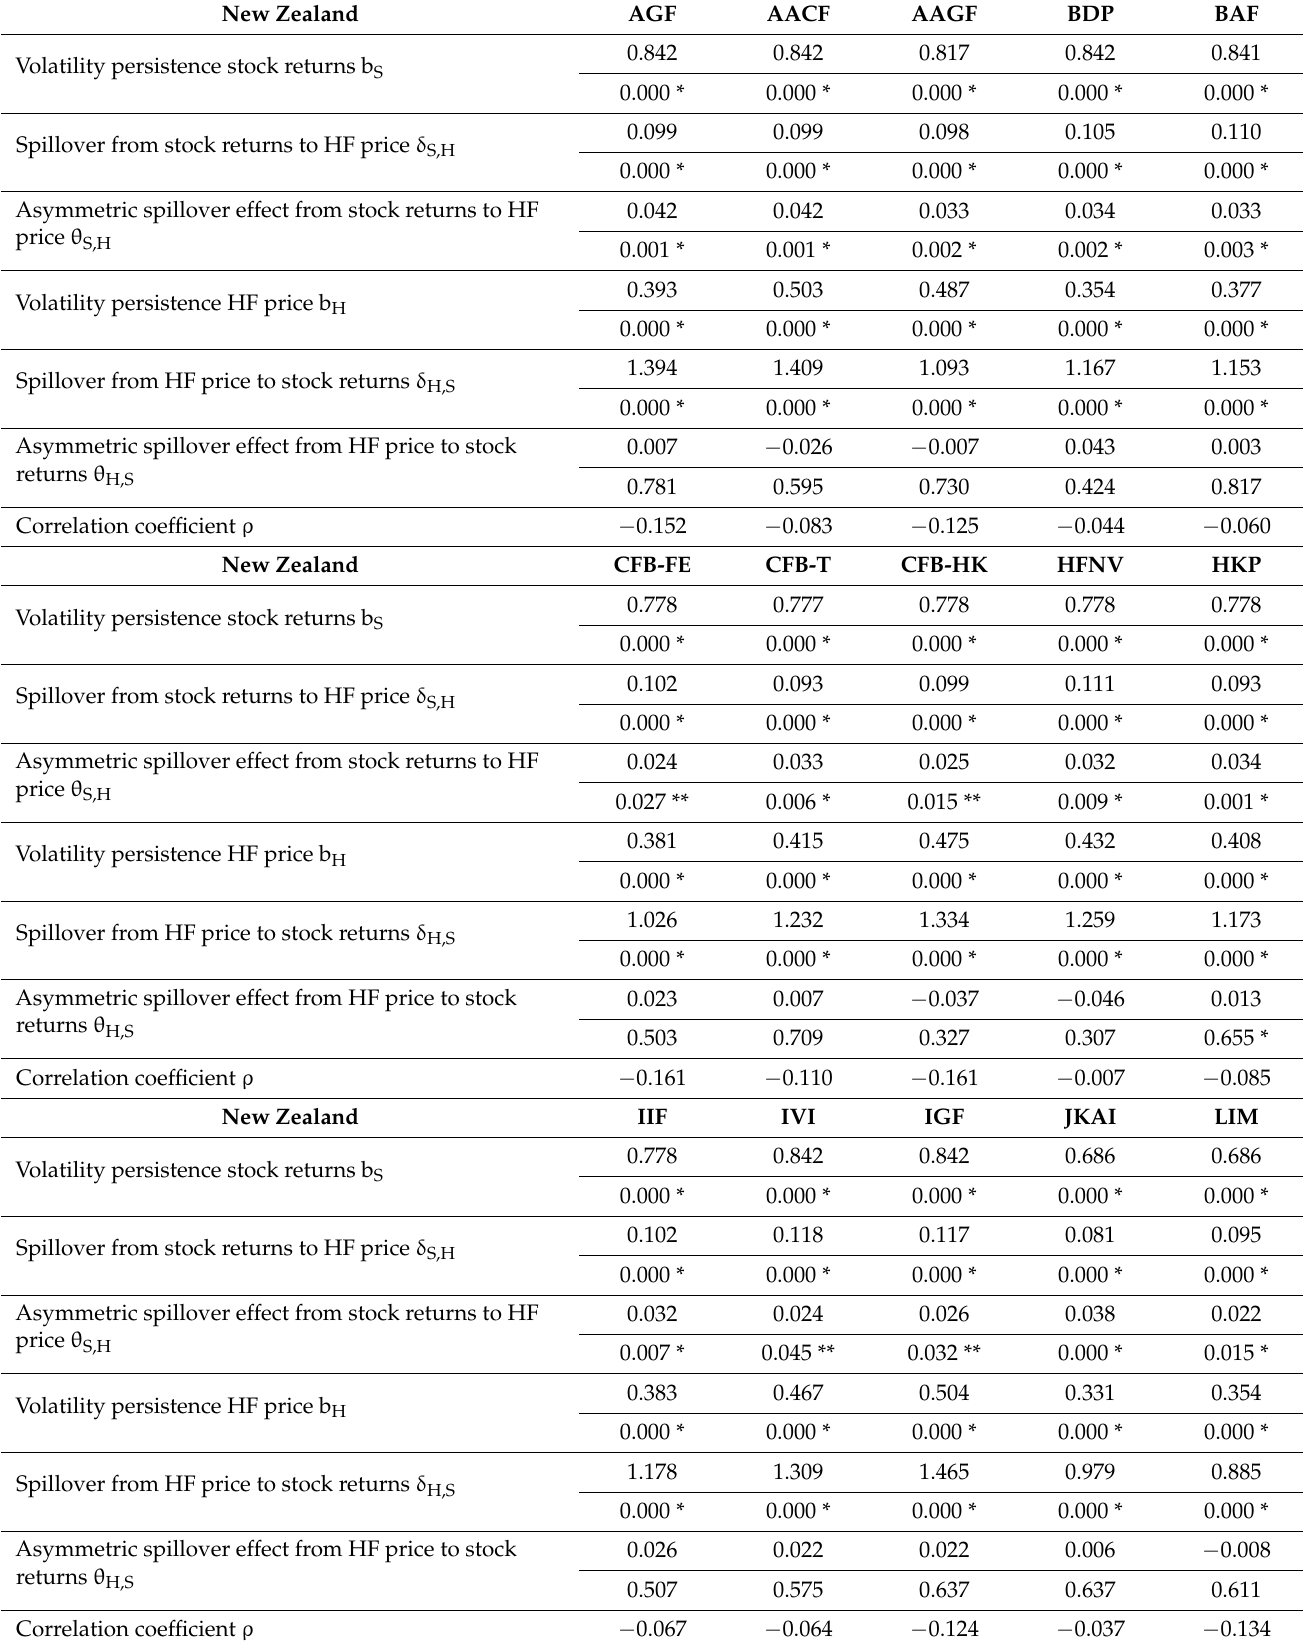
Table 3. The Volatility spillover between the New Zealand Stock Market (NZX) and Hedge Fund